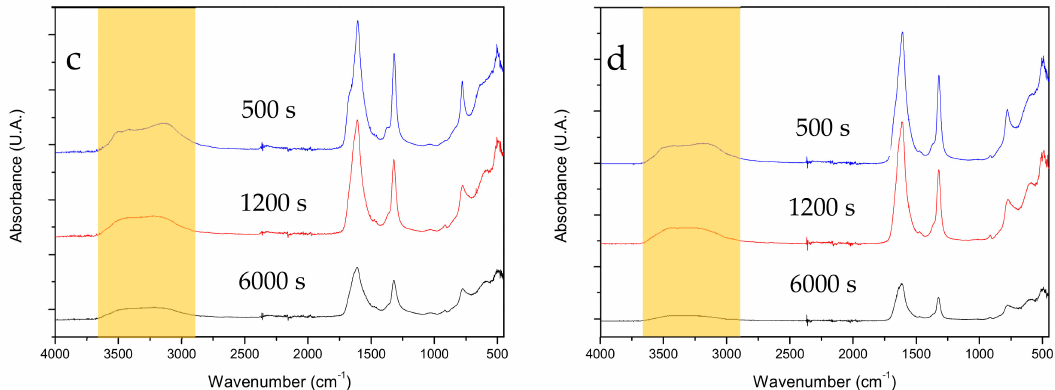
Figure 6. FTIR spectra of CaOx particles obtained in post-nucleation stage at 500, 1200 and 6000 s. ( a ) without PAA, ( b ) with 10 mg/L PAA, ( c ) with 50 mg/L PAA, ( d ) with 100 mg/L PAA. Light blue and orange shaded bars indicate the characteristic absorption bands of COM and the absorption bands of coordinated water molecules in the COD and COT hydrates, respectively.